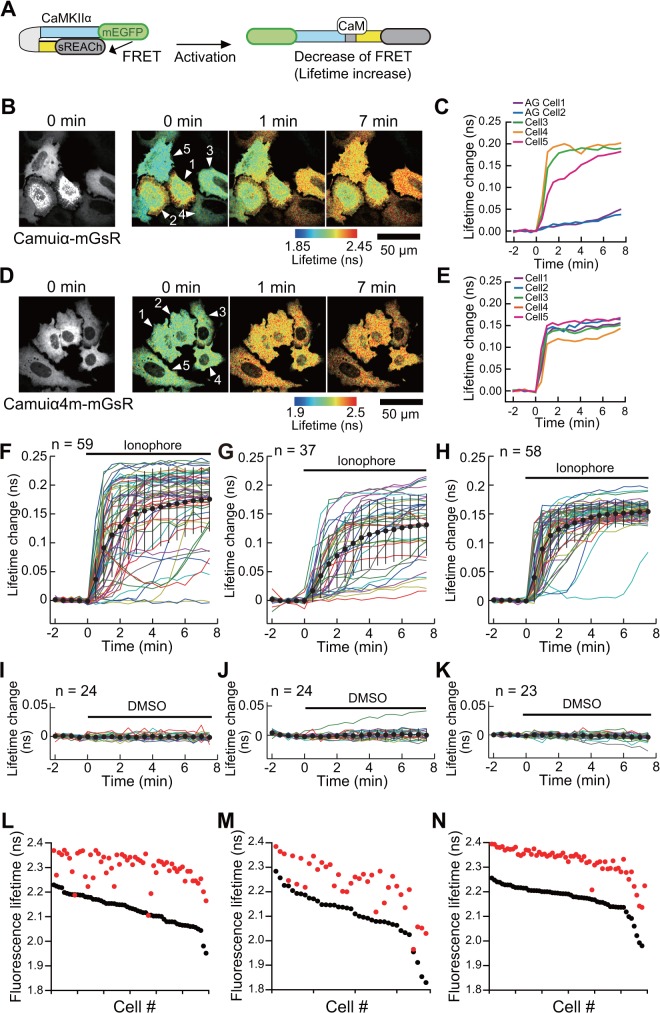
Characterization of Camuiα4m-mGsR mutant activation in living cells.
(A) Schematic drawing of Camuiα activation. When Camuiα is in an inactive state, it is in the compact conformation. The binding of Ca2+/calmodulin induces a structural change, leading to activation. Since the structural change is associated with activity, FRET measurement can be used to monitor the activity. (B, D) Representative 2-photon fluorescence (left) and 2pFLIM (right) images of Camuiα-mGsR (B) and Camuiα4m-mGsR (D) co-expressed with calmodulin (DNA ratio of 1:1) in HeLa cells. The 0-minute time point indicates when 10 μM 4-bromo-A23187 ionophore stimulation was applied. Two-photon excitation at 920 nm was used to excite mEGFP in the Camuiα mutant. Scale bar = 50 μm. (C, E) The time course of Camuiα and Camuiα4m activity in the individual cells shown in B and D, respectively. Note that cells with aggregated sensor (AG cells) show only slight activation (e.g., cells 1 and 2 in B and C). (F–K) The activation of evenly expressing Camuiα in HeLa cells following ionophore (F) or DMSO (I) application. The activation of Camuiα in AG cells after ionophore (G) or DMSO (J) application. The activation of Camuiα4m after ionophore (H) or DMSO (K) application. Colored lines represent the response signals from individual cells and the black circles indicate an averaged time course. Error bars represent mean ± SD. The numbers of cells (n) is indicated in the Fig. (L–N) The basal fluorescence lifetimes (average of -2 to 0 minutes) of individual cells are plotted in descending order (black) along with the corresponding fluorescence lifetimes (average of 5.5 to 7.5 minutes) after ionophore stimulation (red). The data from (F), (G), and (H) are used in (L), (M), and (N), respectively.